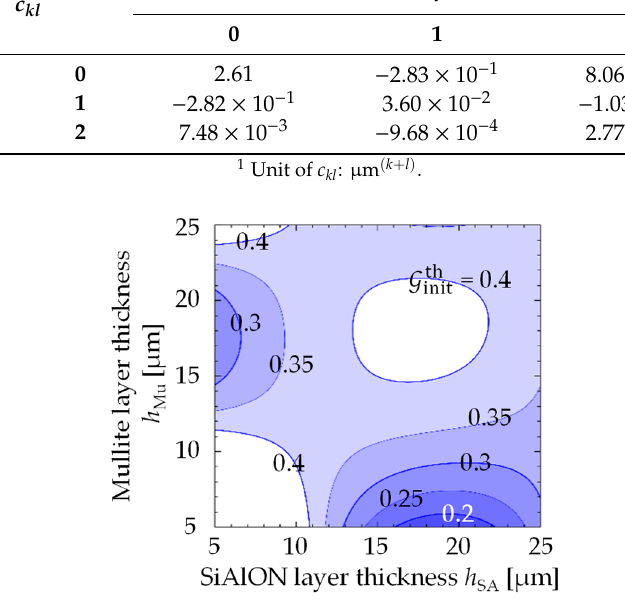
( h ) interpolated with Equation SA , h Mu init,SA/Mu